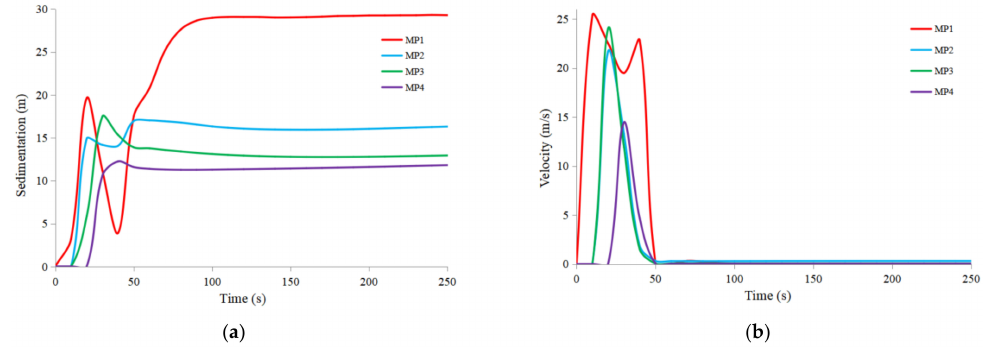
Figure 13. Variation curves of tailing sand accumulation height and flow rate with time at each monitoring point. ( a ) Height–time curve of tailing sand accumulation at each monitoring point; ( b ) velocity–time curve of sand flow at each monitoring point.